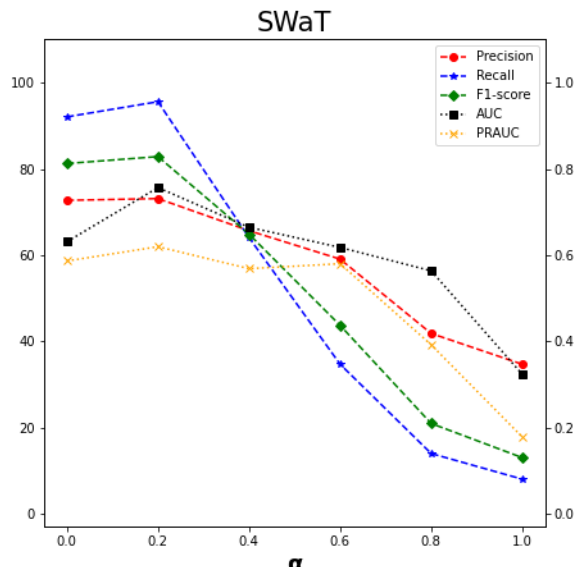
Figure 6. These line graphs show the effect of setting different hyperparameter α on each metric, α ∈ { 0,0.2,0.4,0.6,0.8,1 }